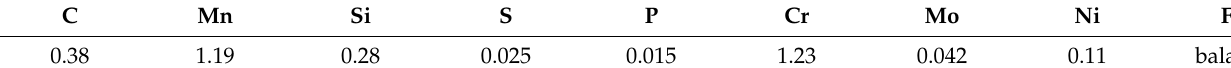
Table 1. Chemical compositions of SAE 5137H steel.